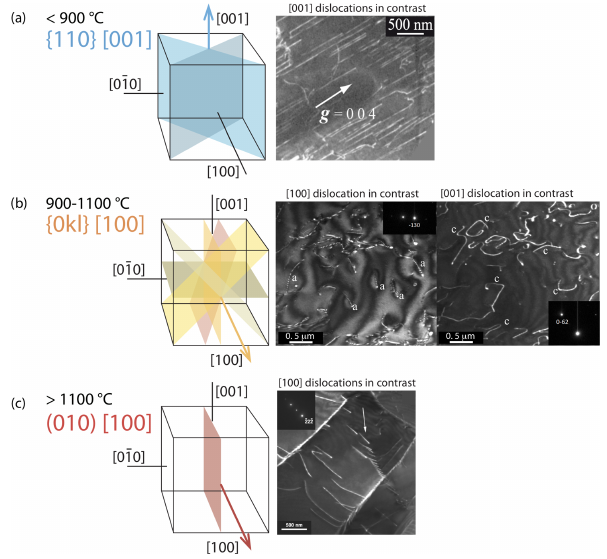
Figure 7. Typical dislocation slip systems in olivine as a func- tion of temperature (redrawn from Carter and Avé Lallemant, 1970): (a) [001] dislocation, typical of low-temperature creep, TEM weak-beam dark-field micrograph from Demouchy et al. (2014); (b) [100] and [001] dislocations co-existing at 1080 ◦ C, TEM weak- beam dark-field micrograph of sample PoEM-8 from Demouchy et al. (2013); and (c) [100] dislocation, sample PI-0546 from De- mouchy et al.